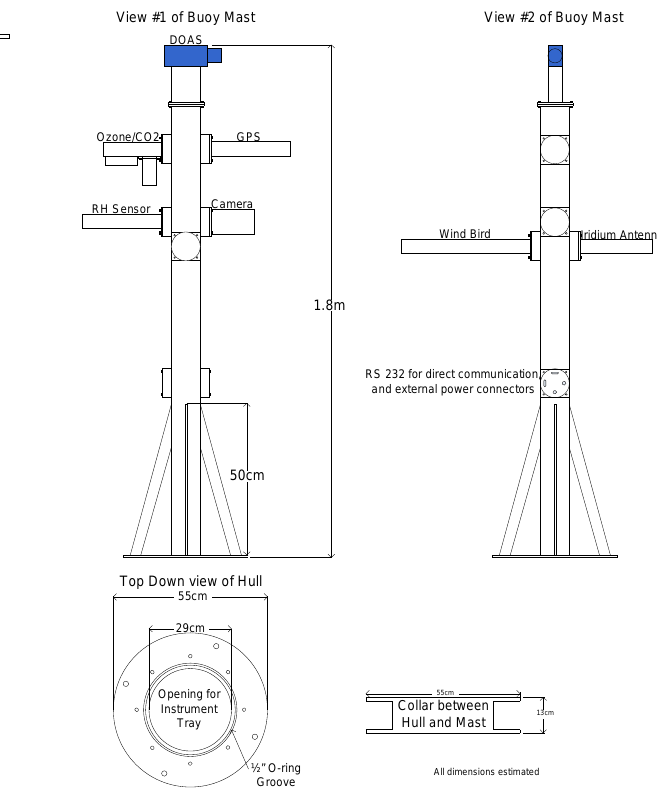
Fig. 2. A schematic representation of the O-buoy’s mast and hull- to-mast connecting collar. View 2 is a rotation of view 1 about the y-axis by 90 ◦ to allow visualization of all instrument/inlet mounts on the